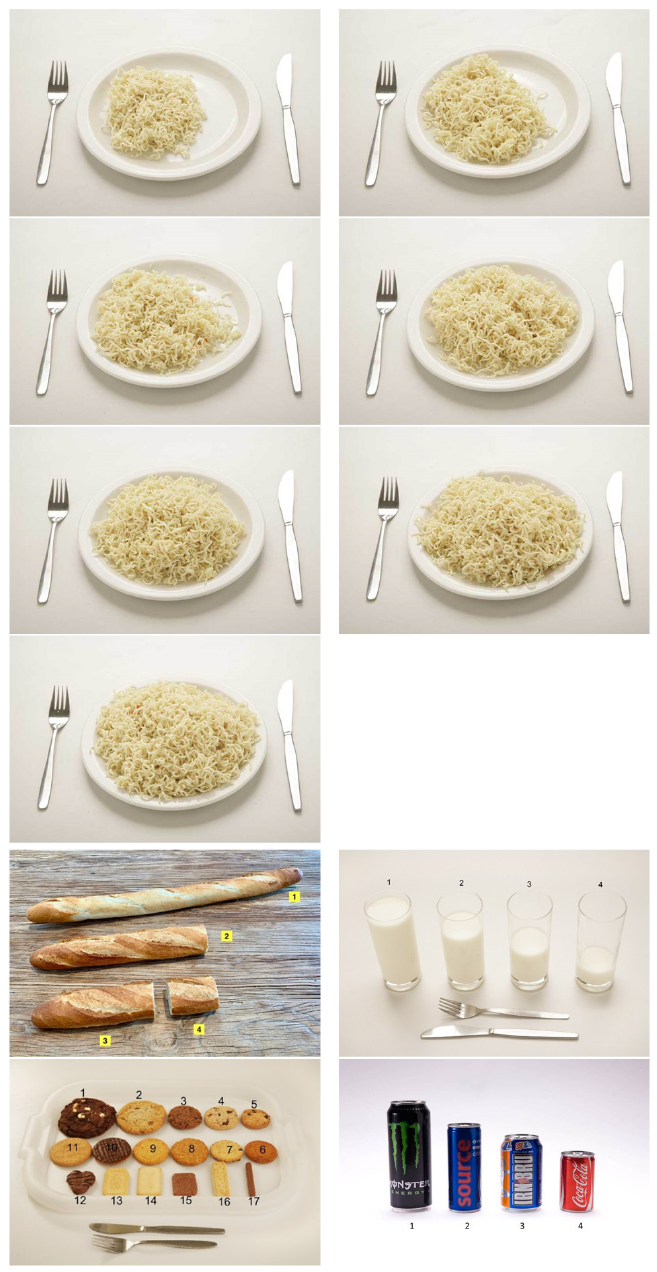
Figure 3. Formats of portion size images for foods and beverages, as served or in a group.